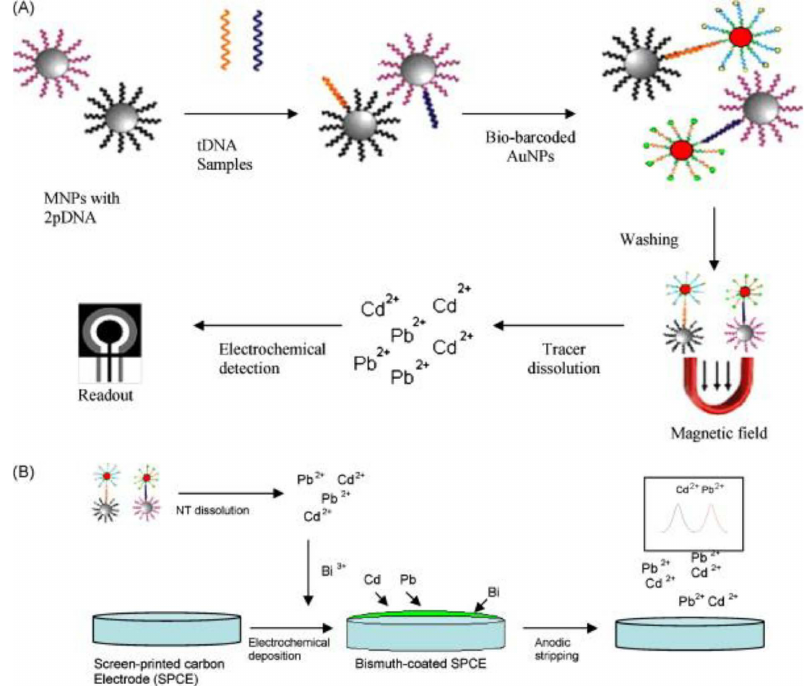
Figure 12. Schematic display of: ( A ) bio-barcode assay for the detection of protective antigen A ( pagA ) gene of B. anthracis and insertion element ( Iel ) gene of S. enteritidis ; and ( B ) square-wave anodic stripping voltammetry. Reprinted from Ref. [95] with